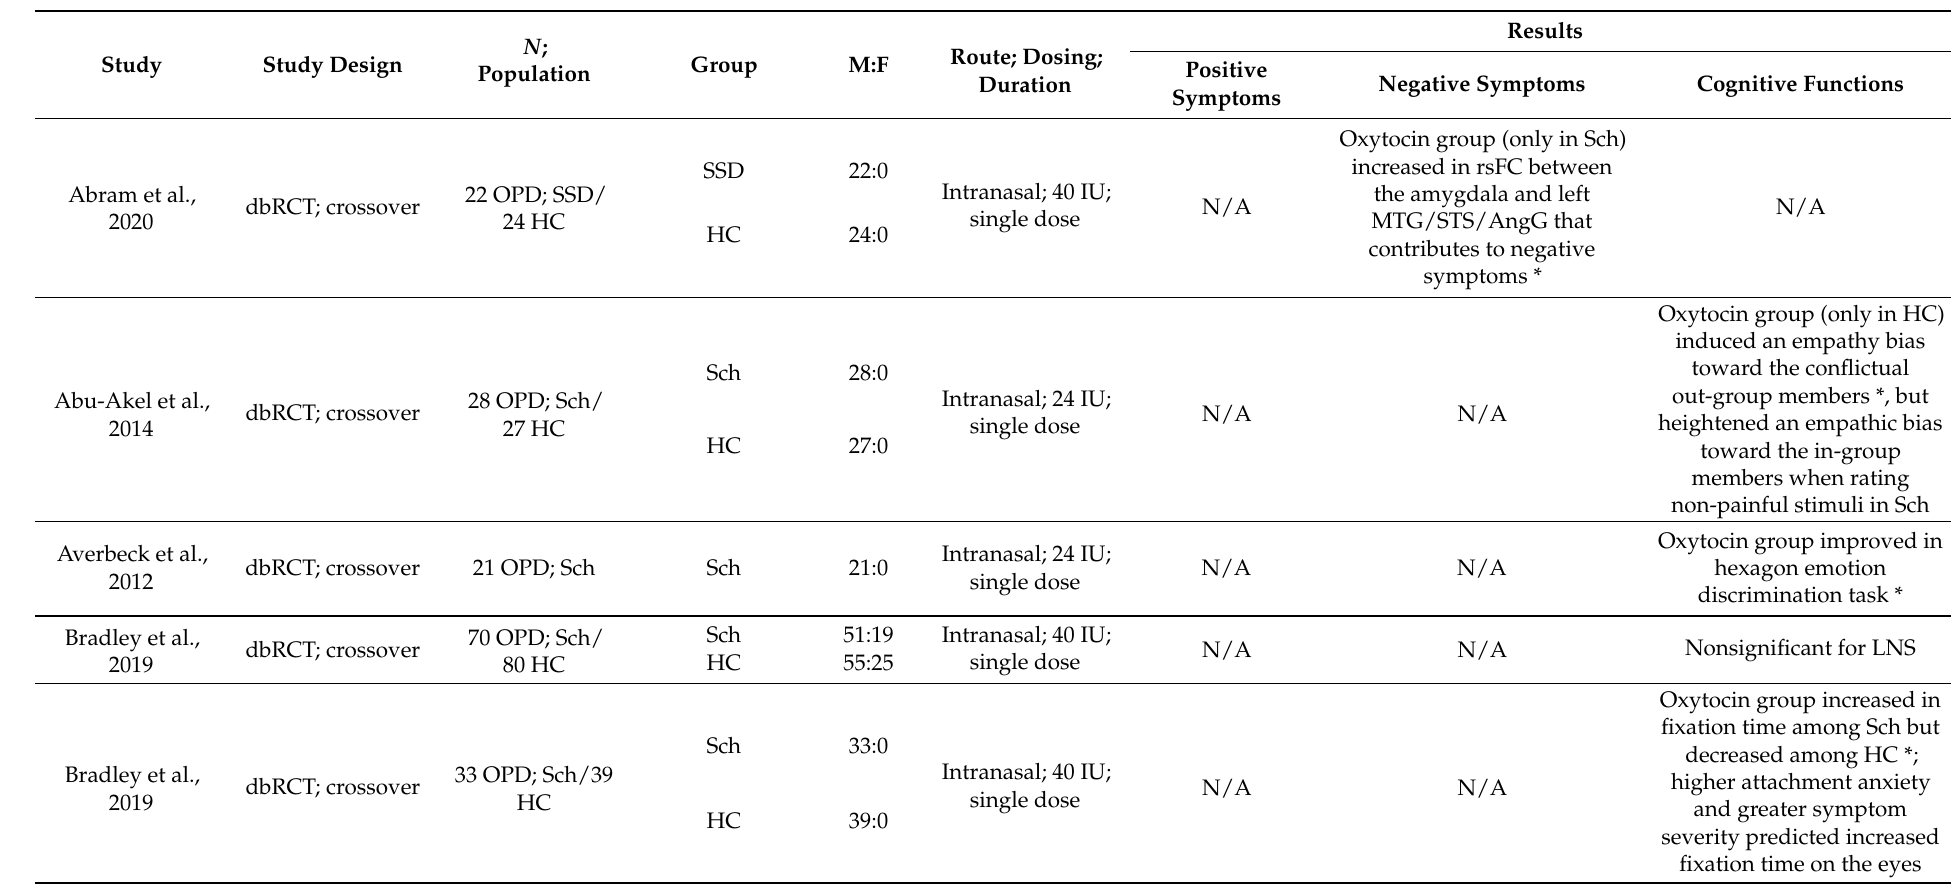
Table 1. Studies of oxytocin treatment in patients with schizophrenia stable on